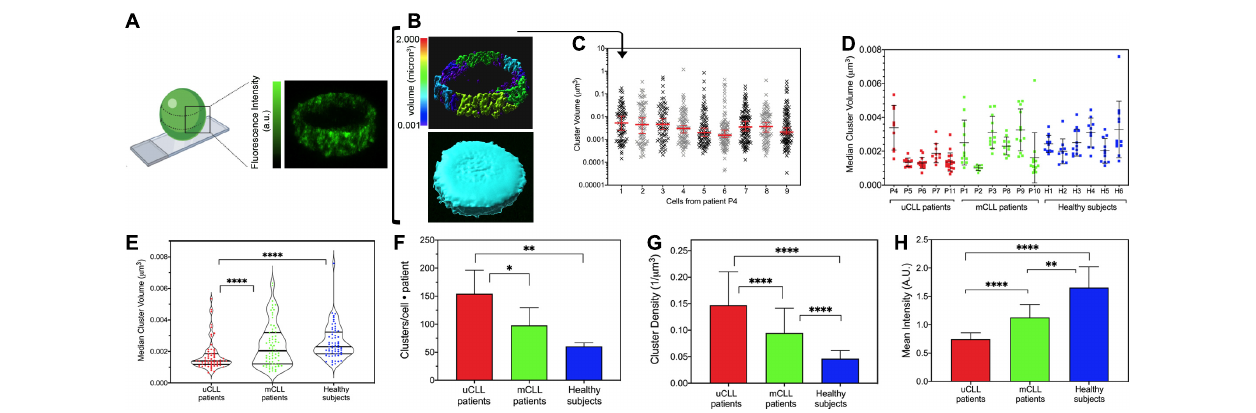
FIGURE 2 | Cluster analysis in primary CLL and healthy B cells. (A) Schematic representation created by www.biorender.com that illustrates the position chosen for the analysis of Alexa 488-immunolabeled HS1 clusters (right) and a representative single-cell STED Z-stack (left). (B) Example of the IMARIS cluster analysis (rainbow volume scale, top) and of the total volume enclosing the clusters used for data normalization (turquoise, bottom). Size is expressed in µ m 3 . (C) Representative clusters measured in nine primary cells from patient P4. Data are plotted in log-Y scale, and the median and interquartile ranges are shown (red bars). (D) Scatter plot illustrating the median cluster size resulting from the analysis of the cells of each patient. Each dot is the median cluster size in a single cell. Black bars indicate the mean ( ± SD) value for each patient sample. Patients with poor prognosis, uCLL: P4, P5, P6, P7, P11; patients with good outcome, mCLL: P1, P2, P3, P8, P9, P10; normal subjects, HB1–HB6. (E) Violin plot resuming the cluster size distribution per group of patients and healthy subjects. Each dot is the median cluster size in a single cell and patient. Black lines: median distribution with quartiles. uCLL vs. HB: **** P < 0.0001; uCLL vs. mCLL: **** P < 0.0007; mCLL vs. Healthy: not significant. (F) Histogram of total number of clusters normalized by the number of cells and number of subjects included in each group (mean ± SD). uCLL vs. Healthy: ** P < 0.0012; uCLL vs. mCLL: * P < 0.0193; mCLL vs. Healthy: not significant. (G) Histogram of cluster densities (mean ± SD) per group of subjects. Data are normalized for the volume of the Z-stack of each cell, for the number of cells, and for the number of patients/subjects in each group. uCLL vs. Healthy: **** P < 0.0001; uCLL vs. mCLL: **** P < 0.0001; mCLL vs. Healthy: P < 0.0001. (H) Histogram of the fluorescence intensities (mean ± SD) Data are normalized for the number of cells and number of patients/subjects in each group. uCLL vs. Healthy: **** P < 0.0001; uCLL vs. mCLL: **** P < 0.0013; mCLL vs. Healthy: ** P < 0.0001. See Supplementary Table 1 for patients’ details. Two-way ANOVA was applied for the statistical significance in (E–H) . uCLL 64 cells from 5 patients; mCLL 60 cells from 6 patients; Healthy 66 cells from 6 normal